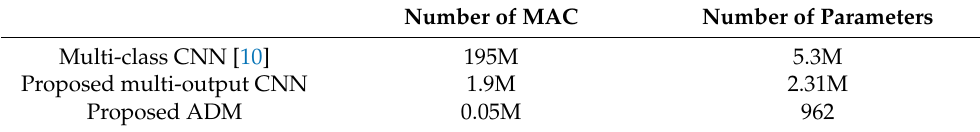
Table 4. Computational consumption comparison between CNN-based methods.